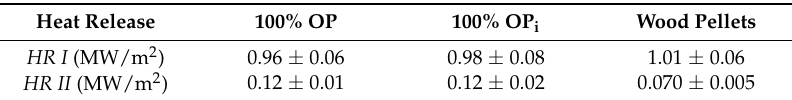
Table 6. Specification Heat Release in the fuel